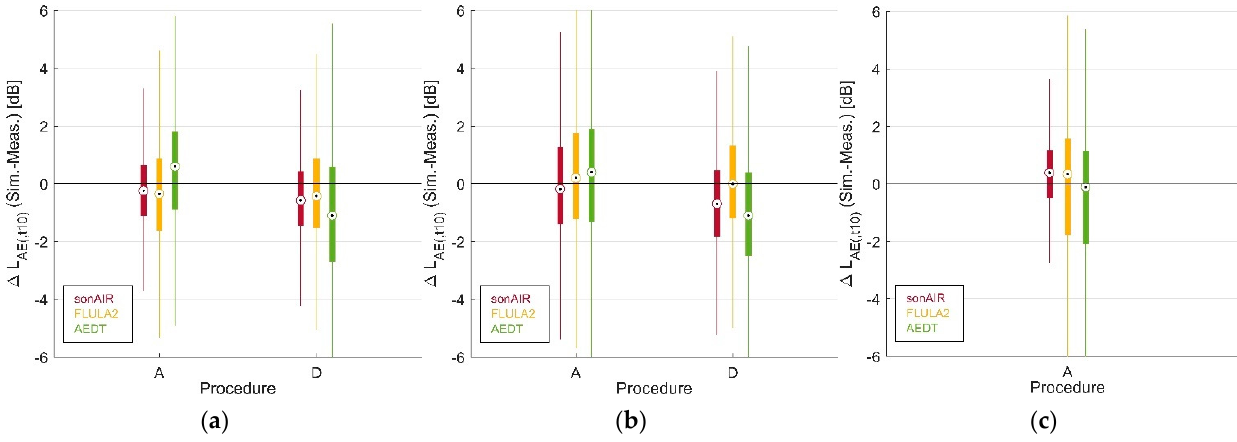
Figure 7. Box-whisker-plots of differences ∆ L AE,t10 for sonAIR and FLULA2 and ∆ L AE for AEDT (simulation minus measurements) for all scenarios, grouped by procedure (D: Departure, A: Approach). ( a ) ZRH & GVA, FDR, close range; ( b ) ZRH & GVA, nonFDR, close range; ( c ) ZRH, FDR, far range.